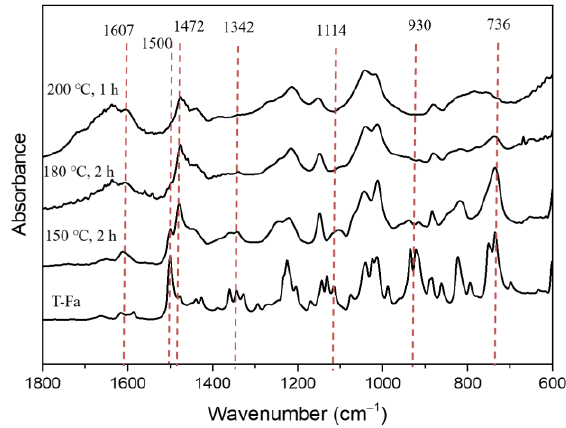
Figure 5. FTIR spectra of T–Fa after step-by-step curing stage (after being cured at 150 °C for 2 h, 180 °C for 2 h, and 200 °C for 1 h).